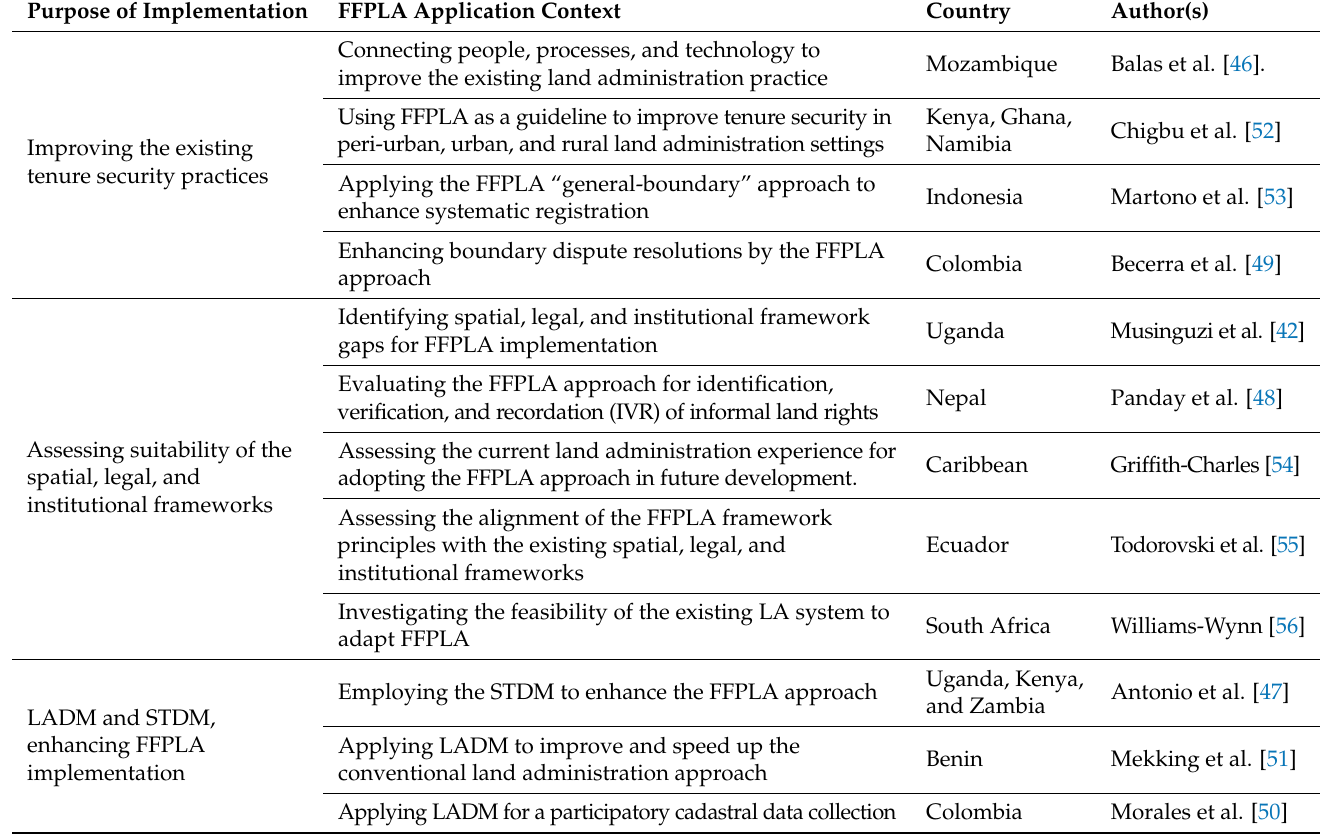
Table 4. Summary of FFPLA implementation practices and